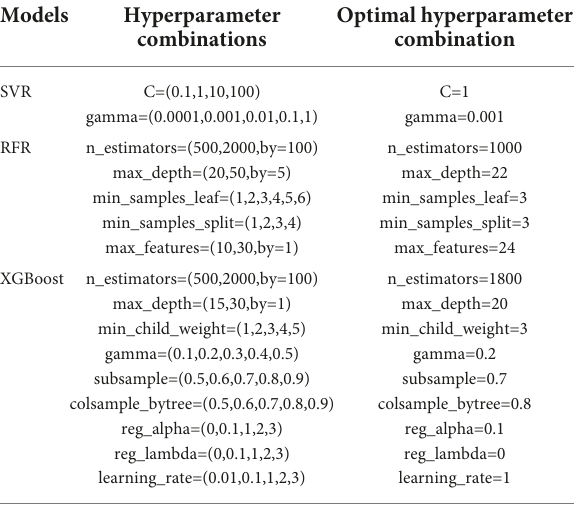
TABLE 2 Optimal hyperparameter combination of the three models.